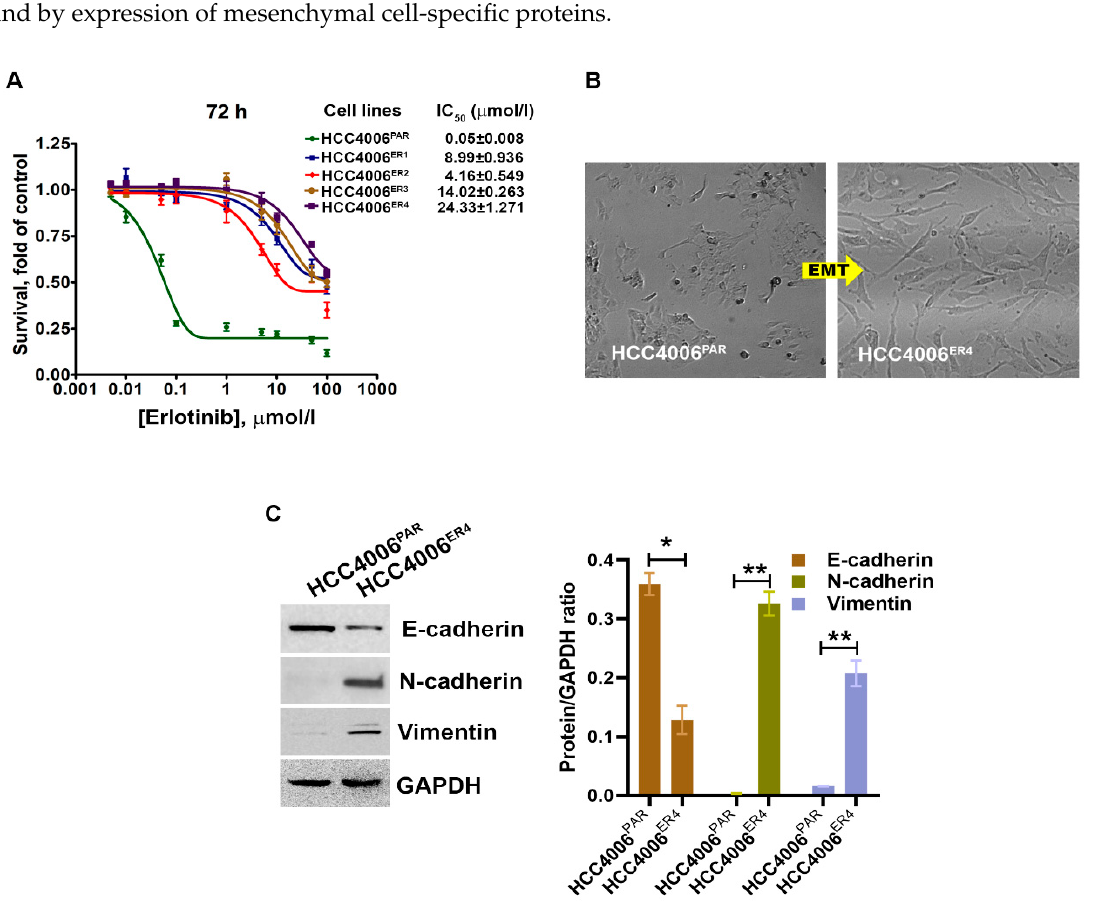
Figure 1. The changes in cell survival and epithelial–mesenchymal transition in NSCLC cells by erlotinib. ( A ) The survival curves of erlotinib-sensitive (HCC4006 PAR ) and erlotinib-resistant cells (HCC4006 ER4 ) in the presence of different concentrations of erlotinib. ( B ) The photomicrographs represent the morphological changes (from epithelial-mesenchymal transition, EMT) in HCC4006 PAR and HCC4006 ER4 cells (Magnification, 10 × ). ( C ) Western blot analyses of EMT markers in HCC4006 PAR and HCC4006 ER4 cells. The right panel shows the semi-quantitative estimation by densitometry analysis of protein bands. For semi-quantitative analysis, E-cadherins, N-cadherins, and vimentin bands are evaluated upon normalization with the corresponding housekeeping GAPDH protein band. Data are expressed as the mean ± SD. * p < 0.001, ** p < 0.0005 when compared with HCC4006 PAR cells.